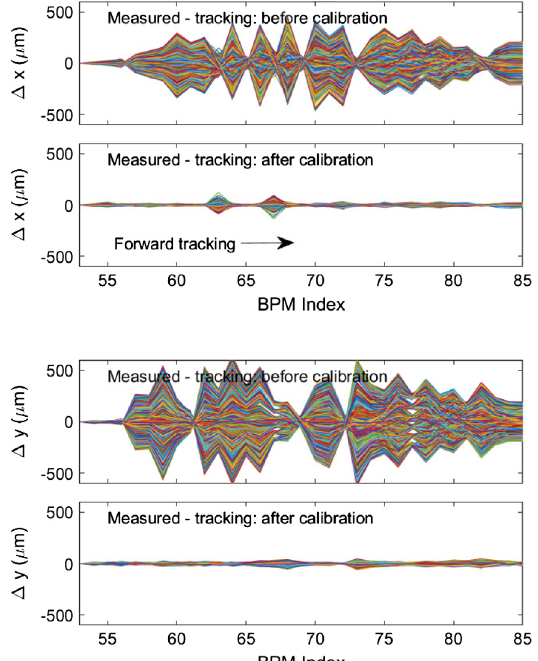
FIG. 15. Trajectory differences between measurements and tracking before and after fitting for the BSY-LTU section using forward tracking. Top: horizontal trajectories; Bottom: vertical trajectories.